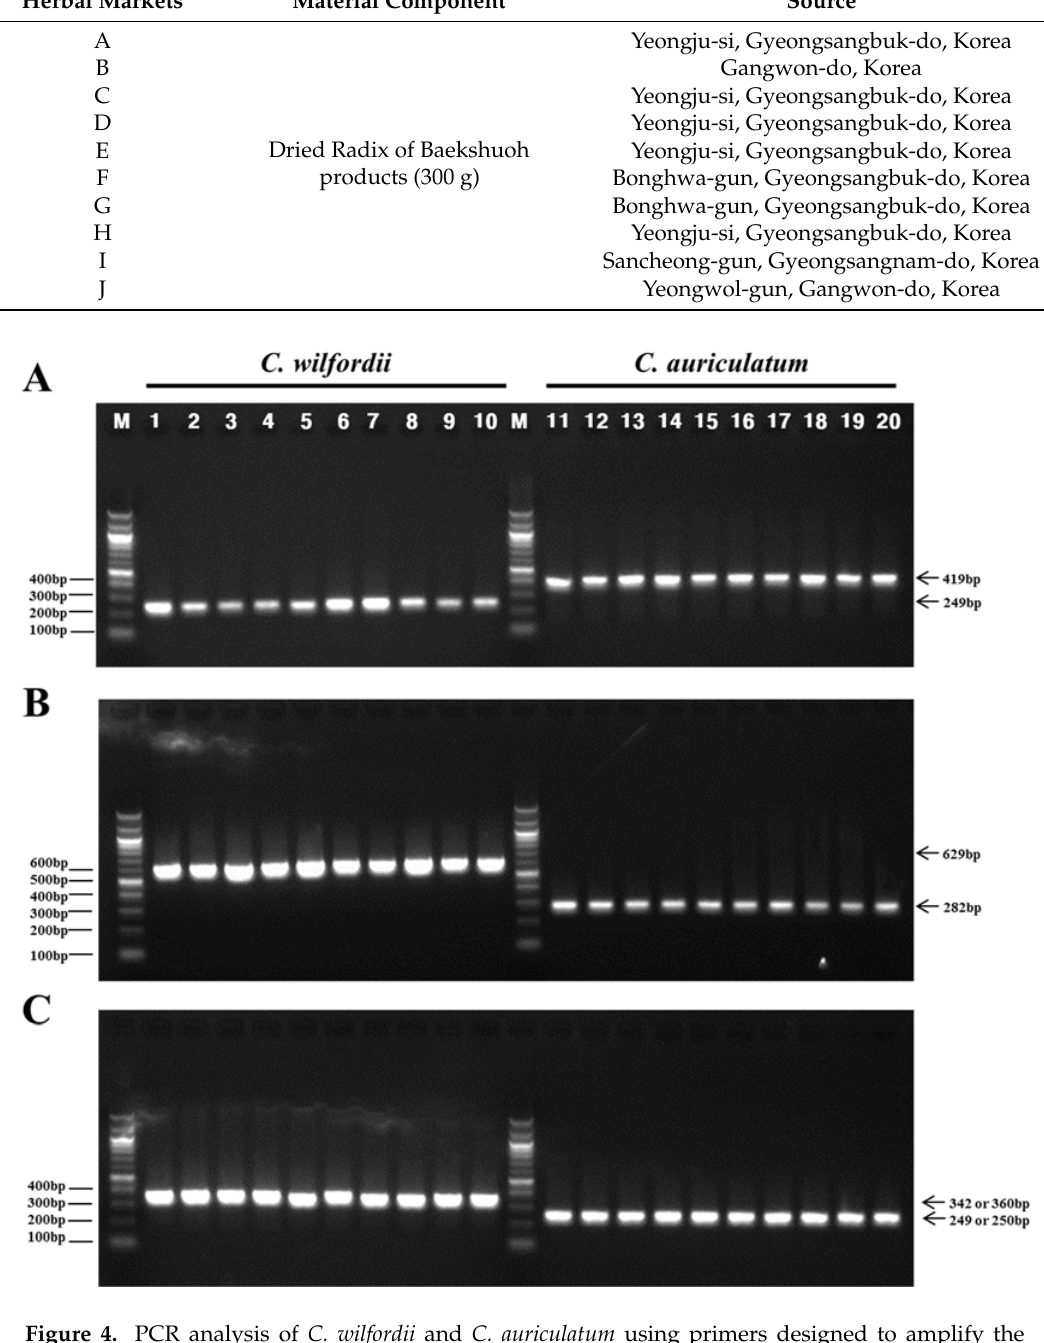
Table 2. Herbal medicine material from 10 commercial dried Baekshuoh products used in this study Herbal Markets Material Component